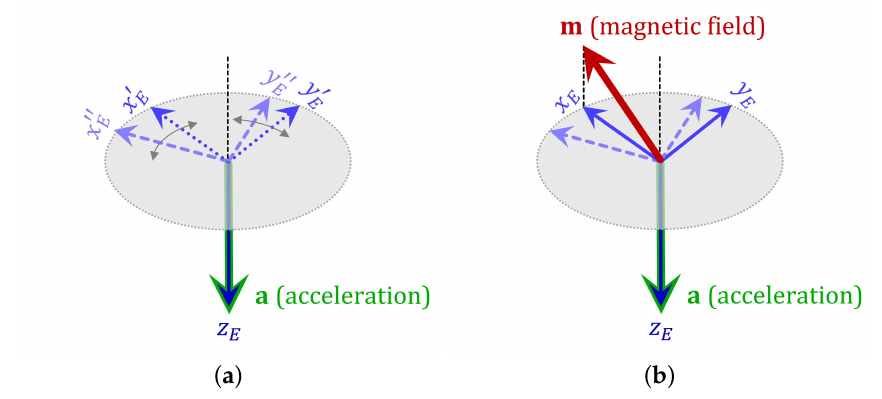
Figure 2. ( a ) With only the acquired acceleration field vector a , there exist infinitely many solutions to the sensor unit orientation (two are shown); ( b ) the acquired magnetic field vector m uniquely identifies the sensor unit